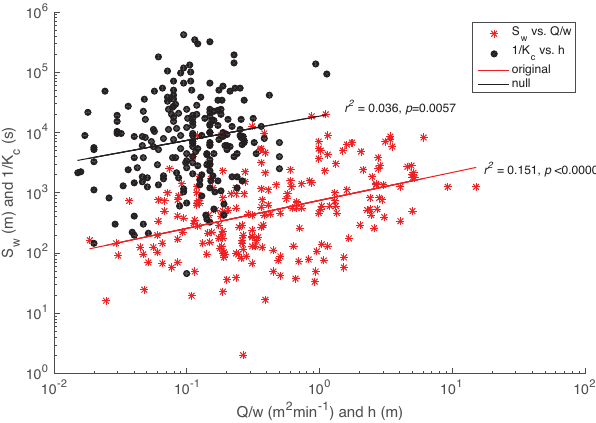
Figure 1. NH 4 scaling relationship with and without shared velocity term. The original relationship is represented by S w vs. Q/w and the null condition by 1 /K c vs. h .